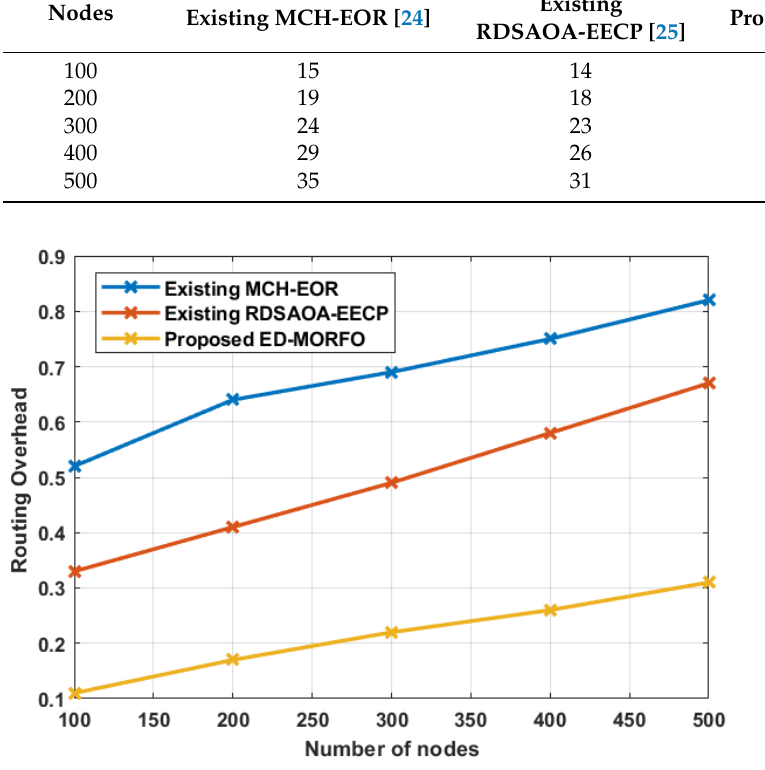
Figure 8. Performance of routing overhead for proposed EDMORFO and Existing MCH-EOR [24], RDSAOA-EECP [25].